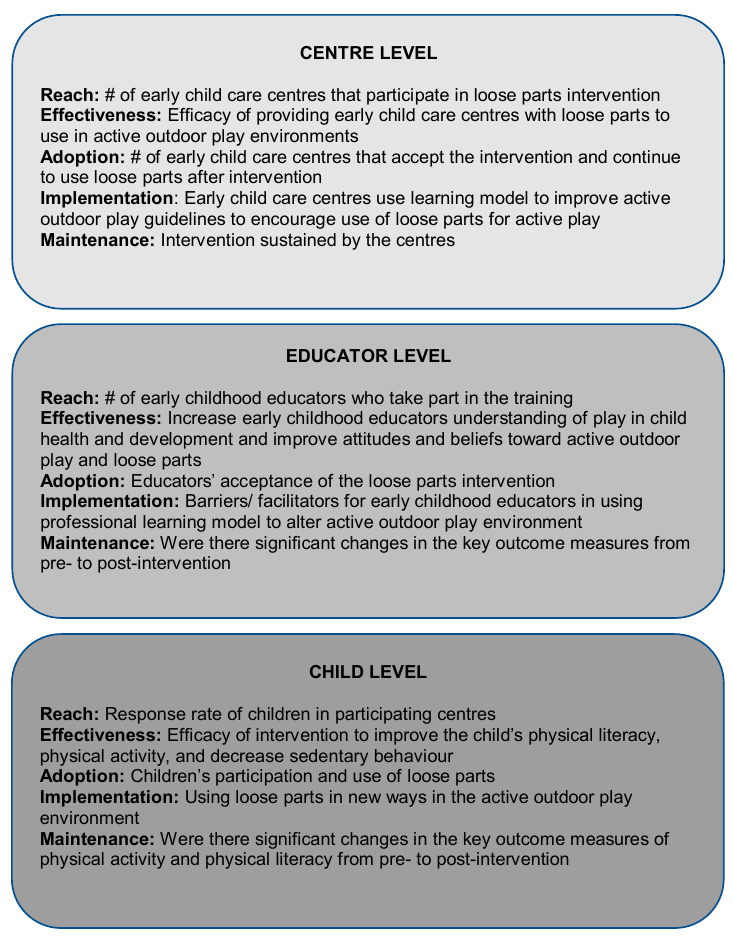
Figure 1. RE-AIM framework outline for the Physical Literacy in the Early Years (PLEY) project.